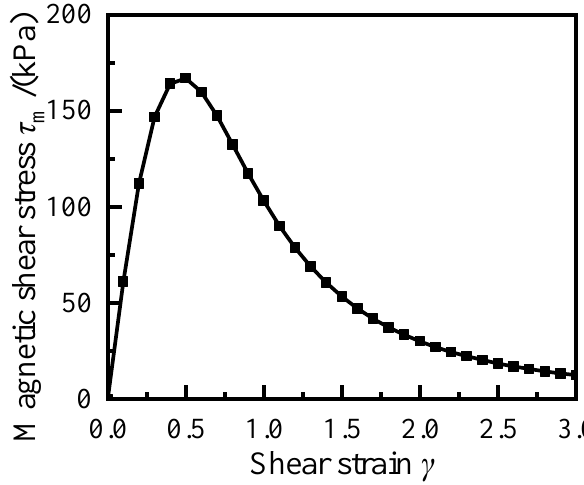
Figure 6. Effect of shear strain on dipoles’ shear yield stress. Now, the MRF is in the case of deformation under axial extrusion, the single chain becomes shorter, bends, and finally aggregates into a more compact and robust BCT structure, in which the chain behaves as low-yield strain and high-yield stress [21]. As the strain increases, the height of the chain decreases, as shown in Figure 7.